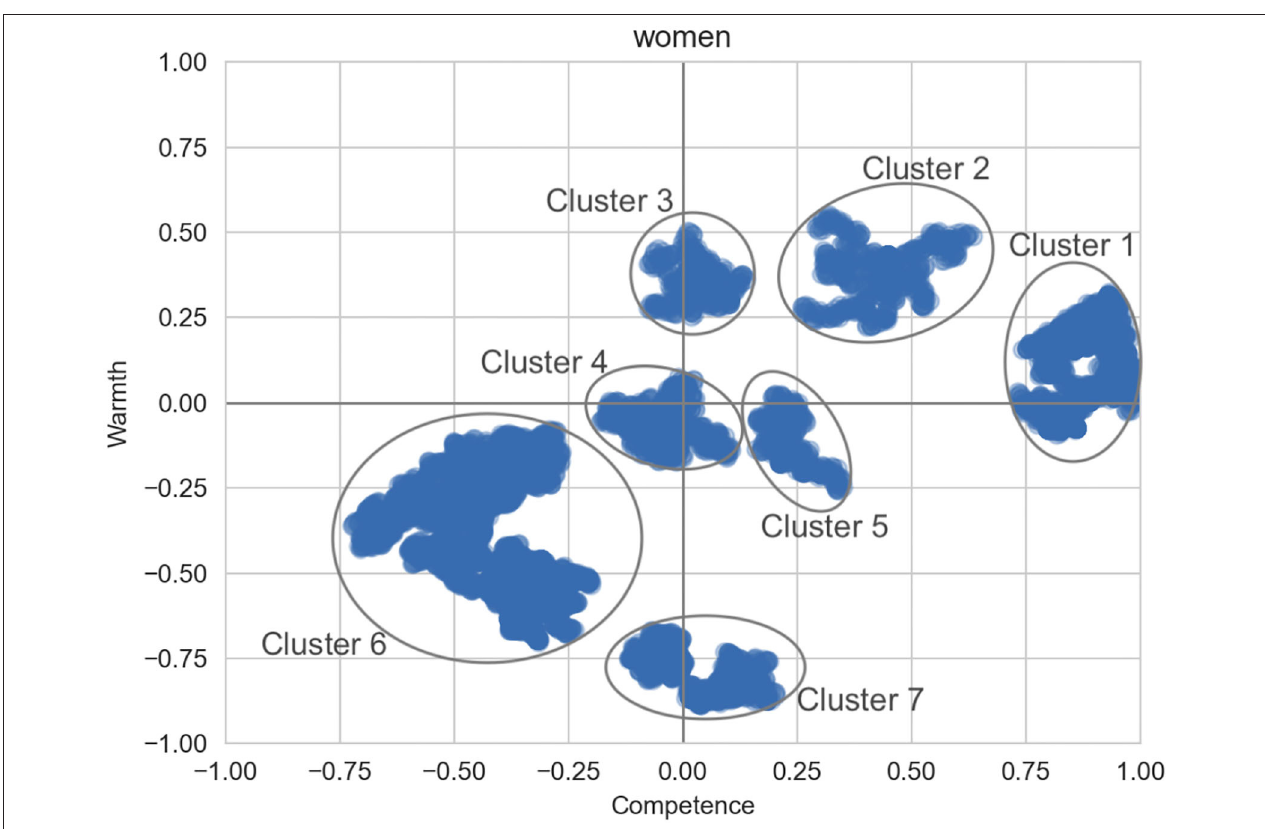
FIGURE 3 | Areas of highest density for the group women .